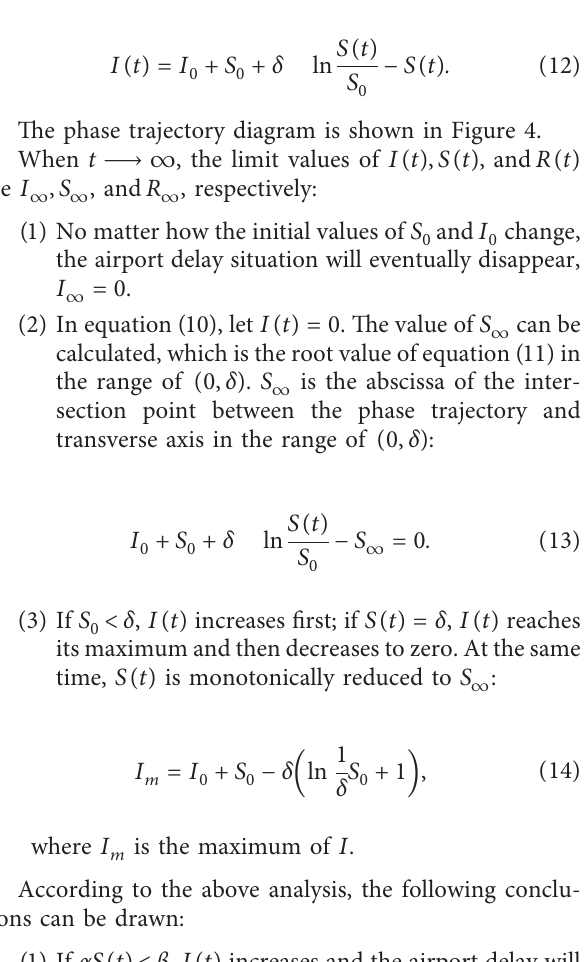
Figure 3: Delay propagation